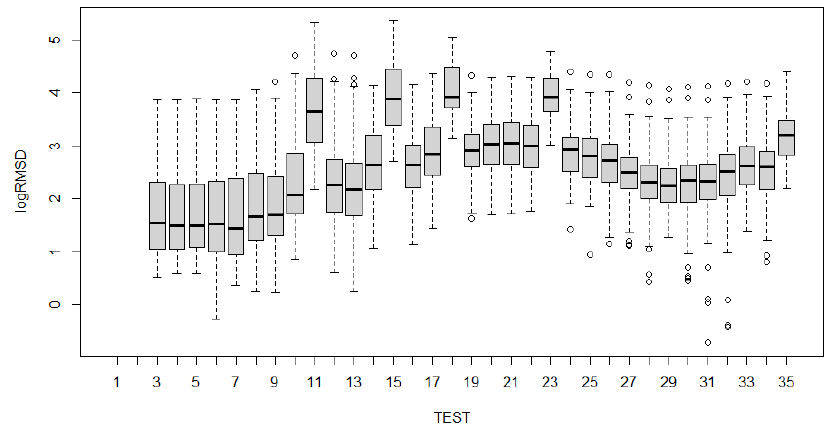
Figure 17. Boxplot for all sensors.